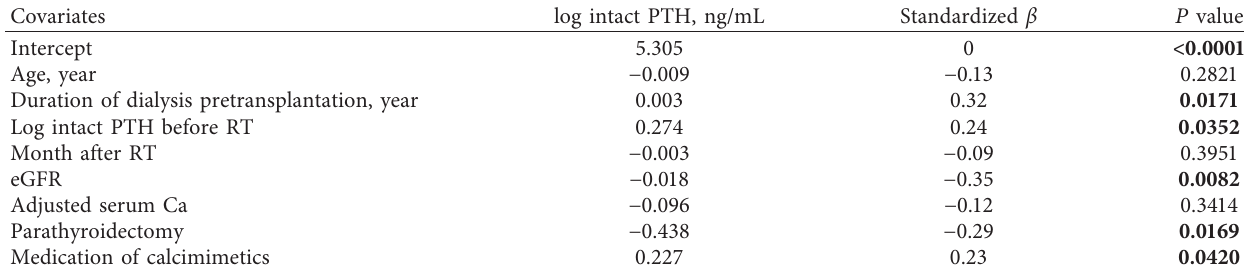
Table 2: Associations between intact PTH after RT and clinical variables.